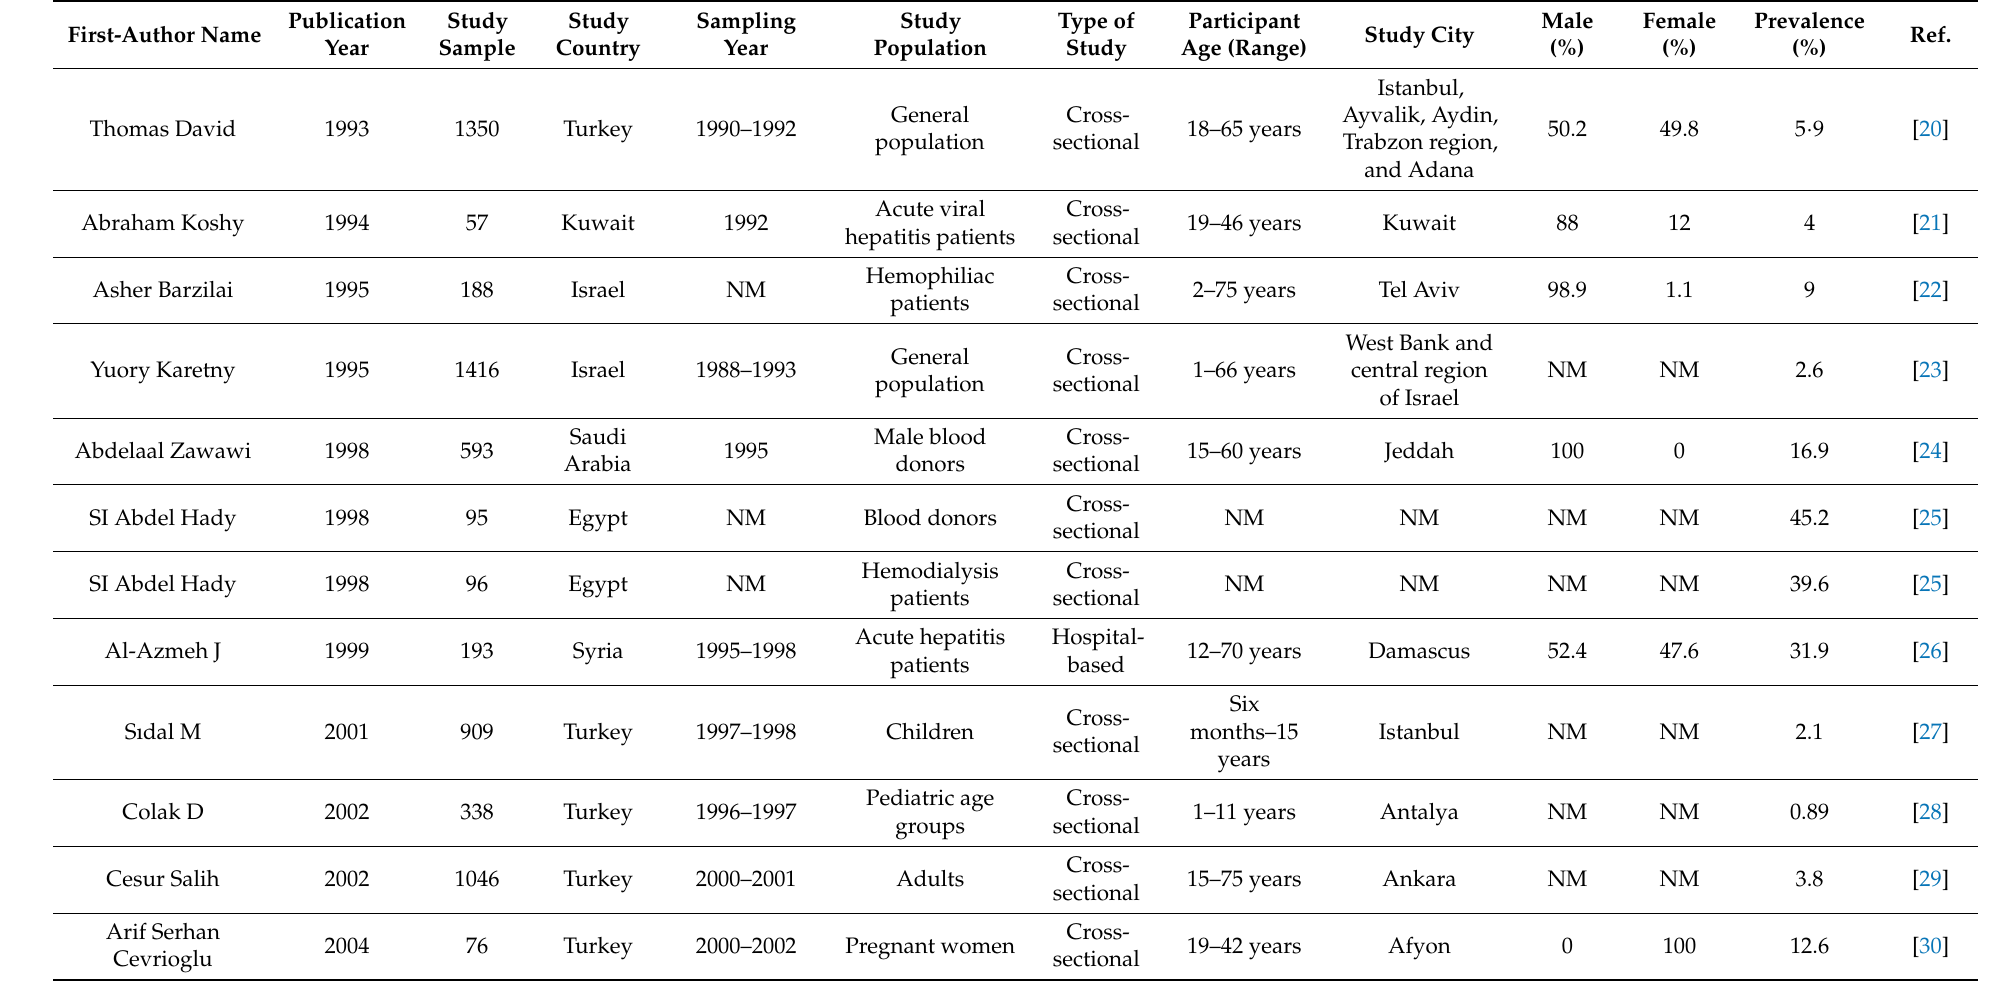
Table 1. Characteristics of the included studies in the systematic review and